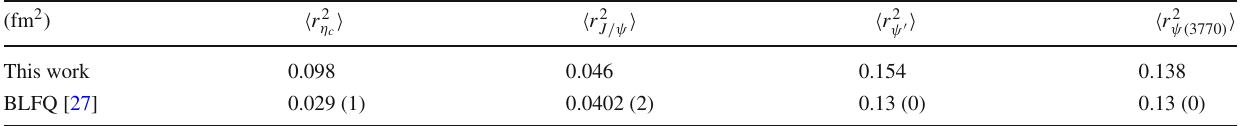
Table 7 The mean squared radii (in fm 2 ) of η c , J /ψ , ψ (cid:2) and ψ( 3770 ) calculated from their constructed